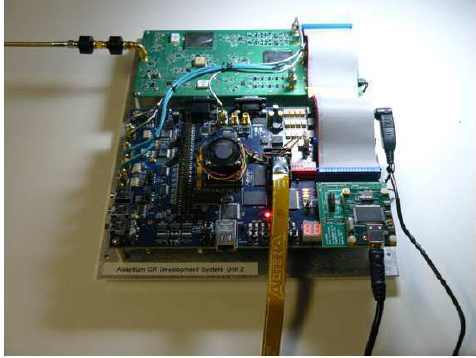
Figure 22. picture of Adaptrum CR prototype